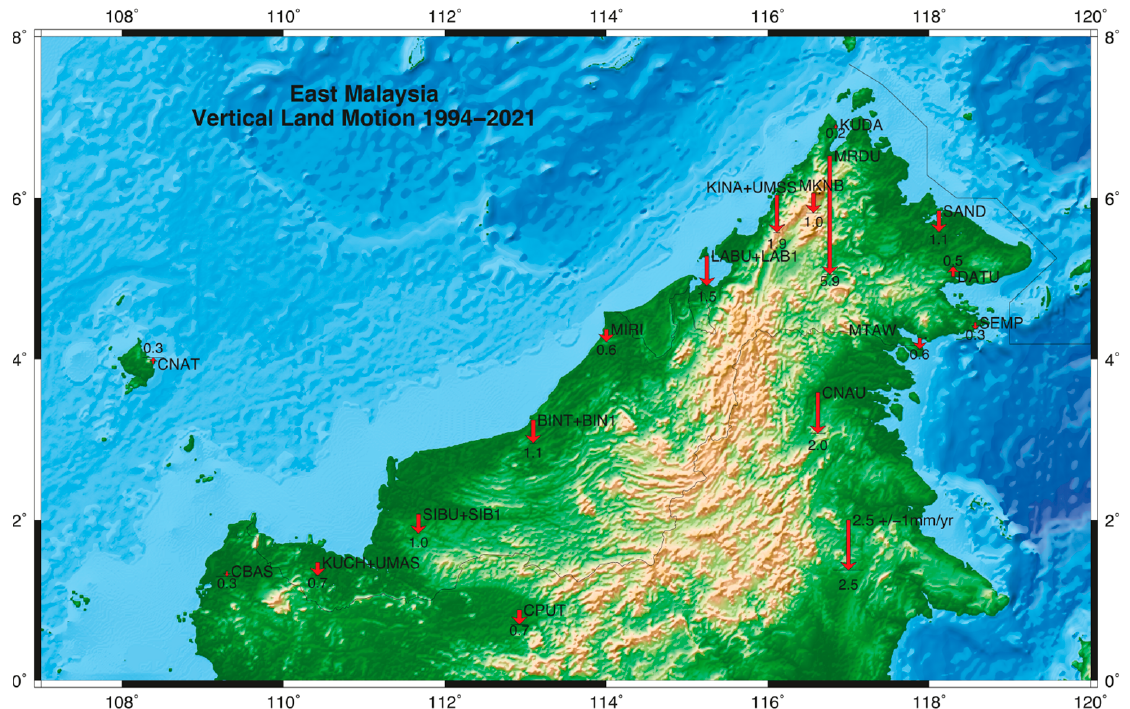
Figure 12. Vertical land motion estimates (1994–2021) in East Malaysia/Kalimantan given as a single VLM trend (1994–2021). The vertical land motion error estimates are given at a 95% confidence level. The y -axis is the latitude (N) and the x -axis is the longitude (E), both given in degrees.